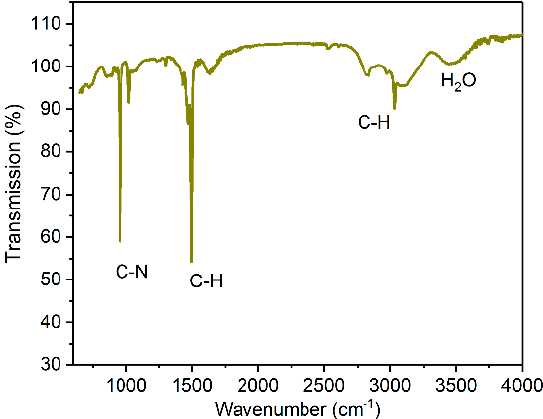
Figure 3. FTIR spectrum of [N(CH 3 ) 4 ] 2 ZrF 6 :1%Mn 4+ sample at room temperature.